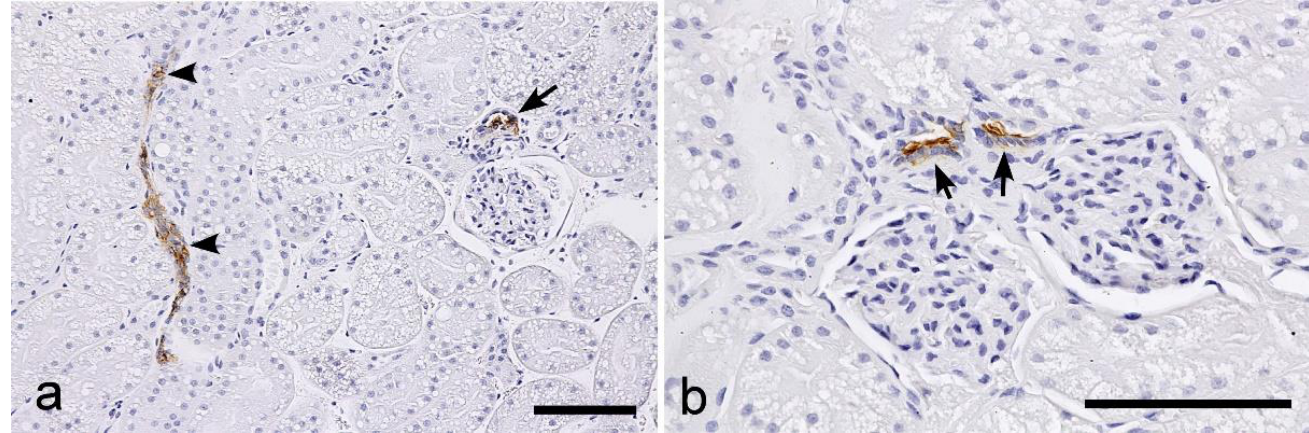
Figure 8. Histochemical staining for Ulex europaeus agglutinin I (UEA-I) in the feline kidney. ( a ) Low magnification view of the cortex. ( b ) High magnification view of the cortex. Positive labeling can be observed in the distal tubules, especially in the macula densa regions (arrows). A few DCTs also show positive labeling (arrowheads). Scale bars: 100 μm .